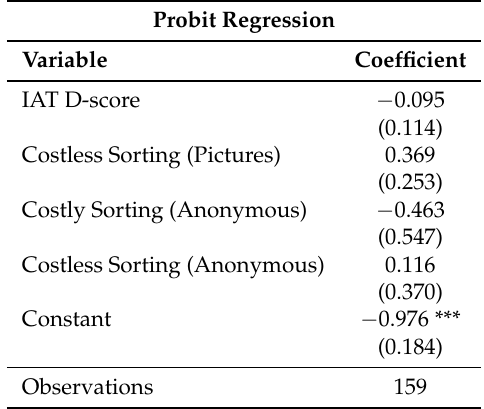
Figure 5. Bar graph of IAT scores and sorting. Table 9. The probability of opting